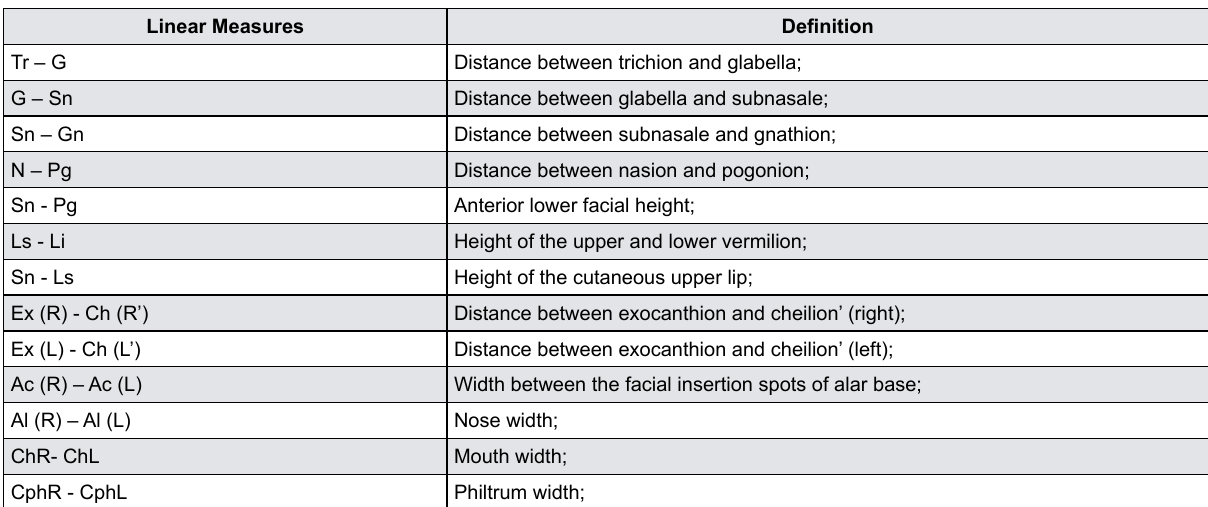
Figure 4- List of abbreviations and definition of linear measures